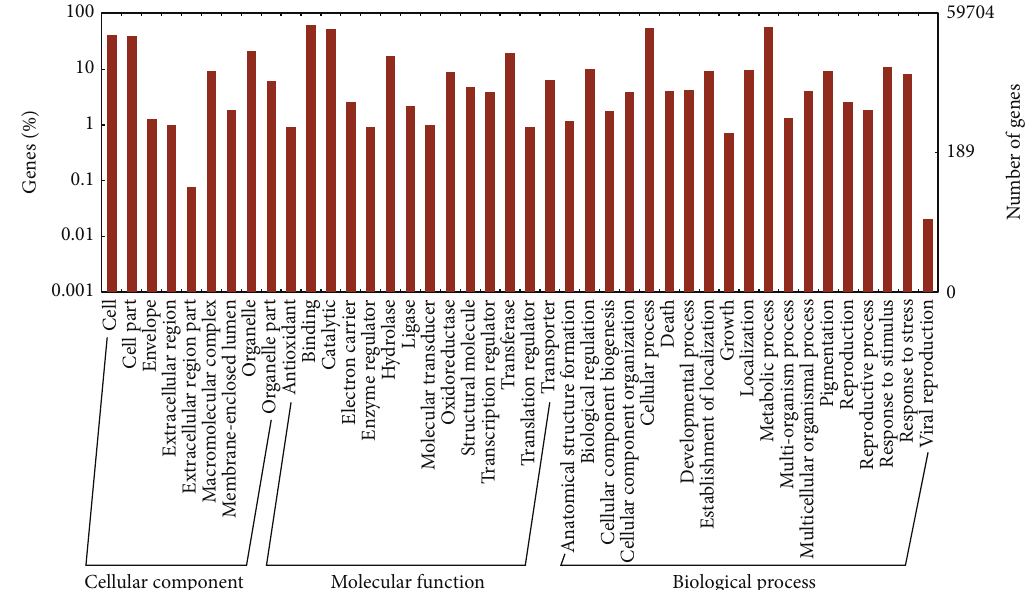
Figure 2: GO annotation results of Thinopyrum elongatum unique transcripts.